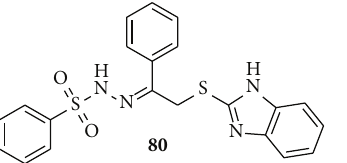
Figure 10: Chemical structure of α -amylase inhibitory active benzimidazole-sulfonamide